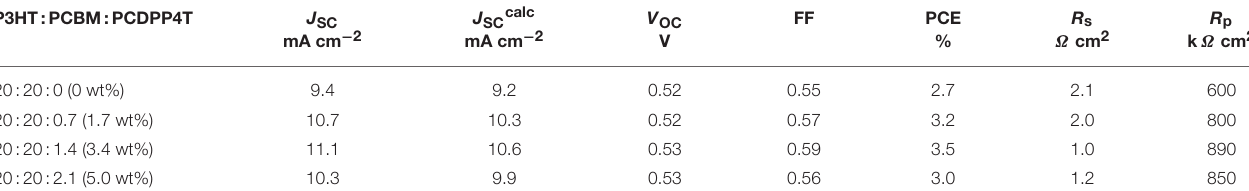
TABLE 1 | Photovoltaic parameters of binary and ternary blend solar